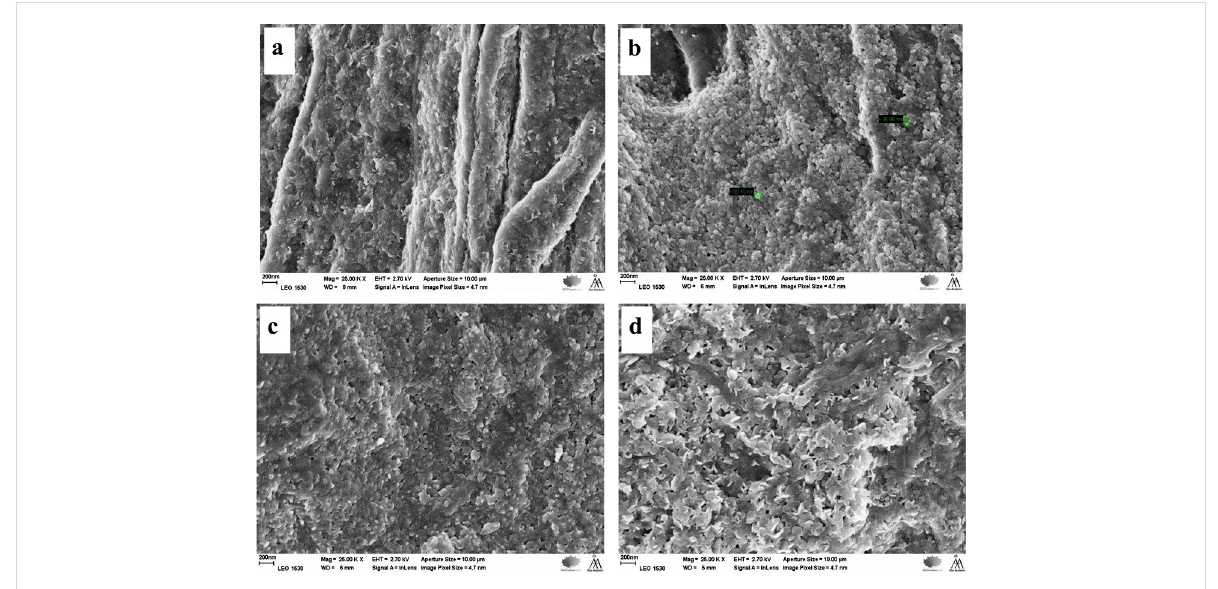
Figure 4: SEM images showing the hybridization of LDH particles on the fiber surfaces of (a) BKP, (b) BKPR, (c) UBKP and (d) UBKPR.